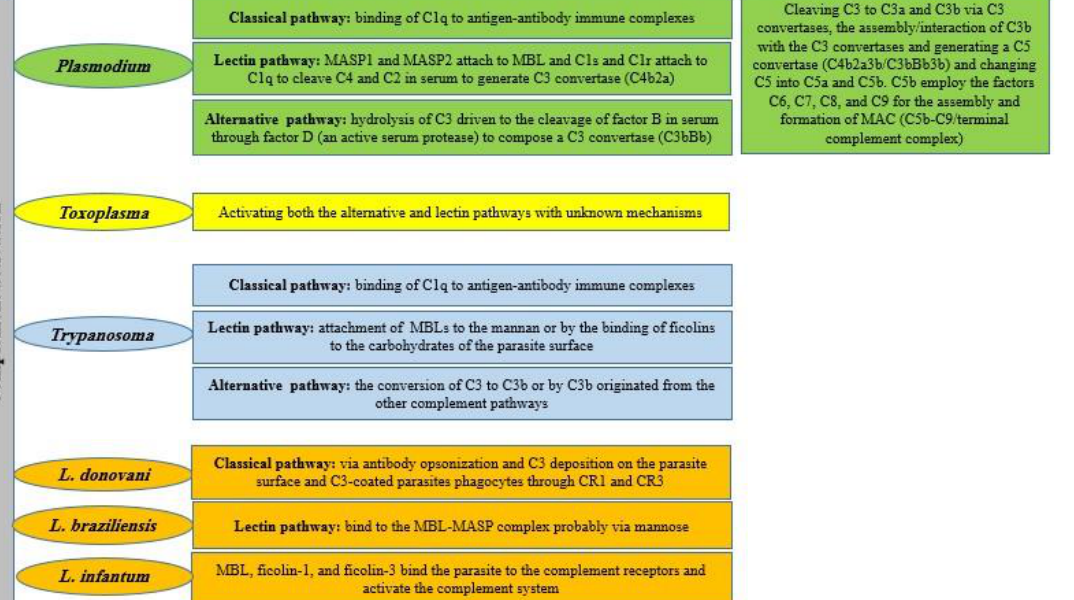
Figure 2. The complement system activation in the most prominent and challenging protozoan parasitic infections [6,16 – 18].